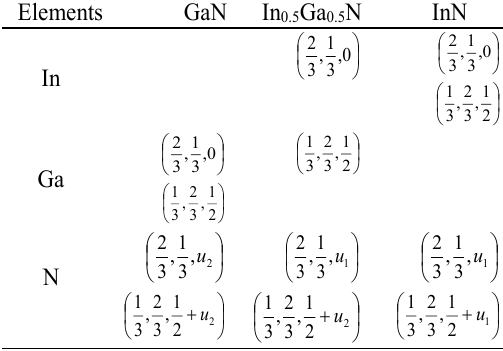
Ga N, from left to right re- 0.5 0.5 is u c 2